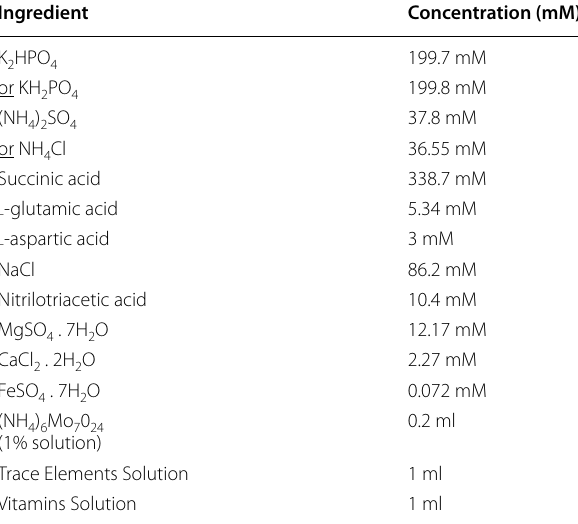
Table 2 Composition of Sistrom’s basal